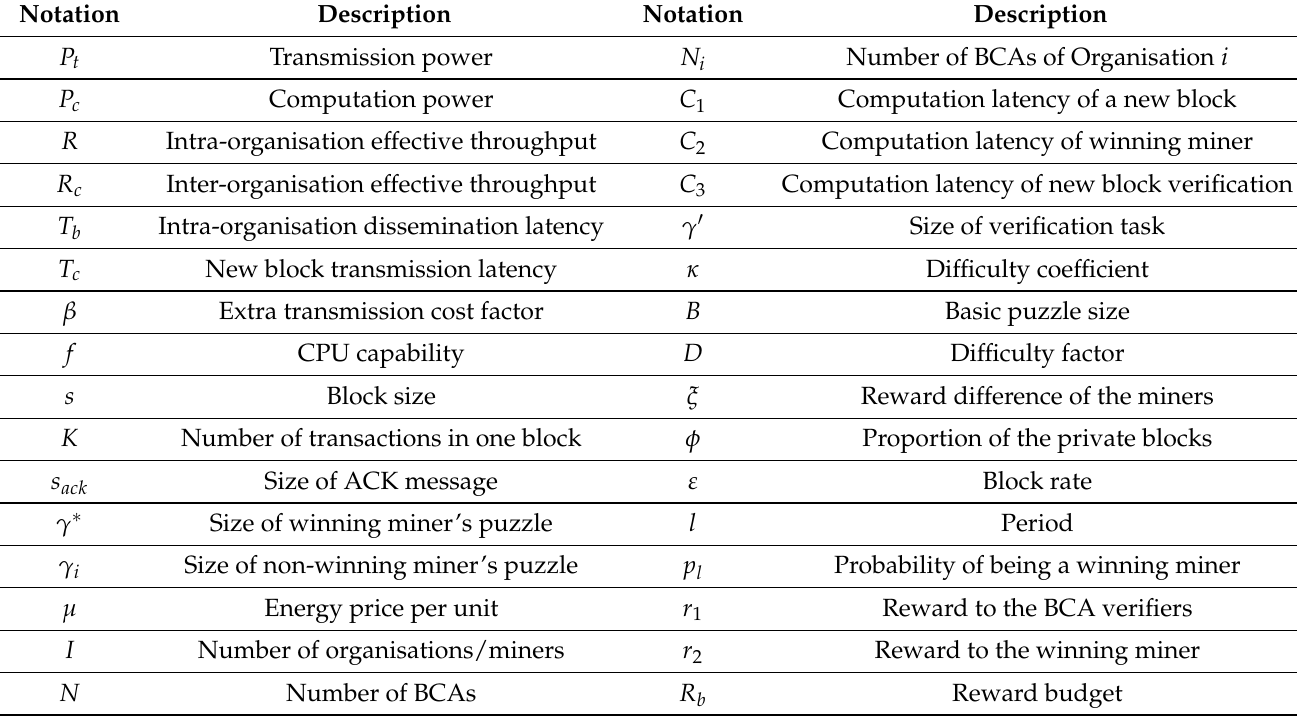
Table 1. Notations and